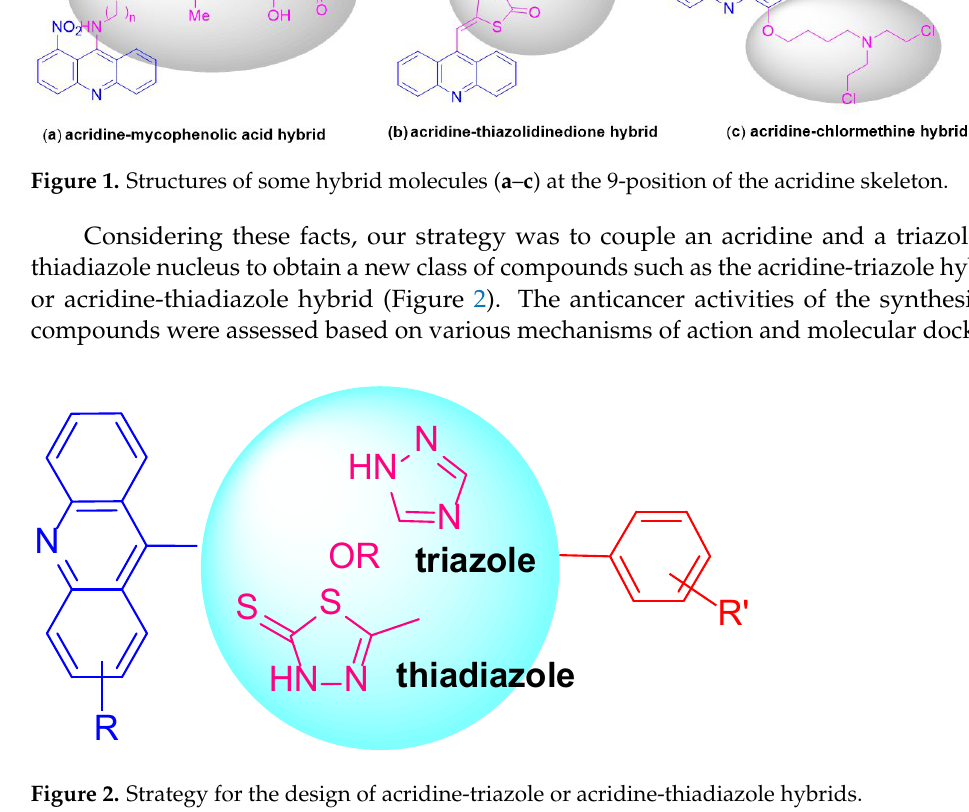
Figure 1. Structures of some hybrid molecules ( a – c ) at the 9-position of the acridine skeleton.